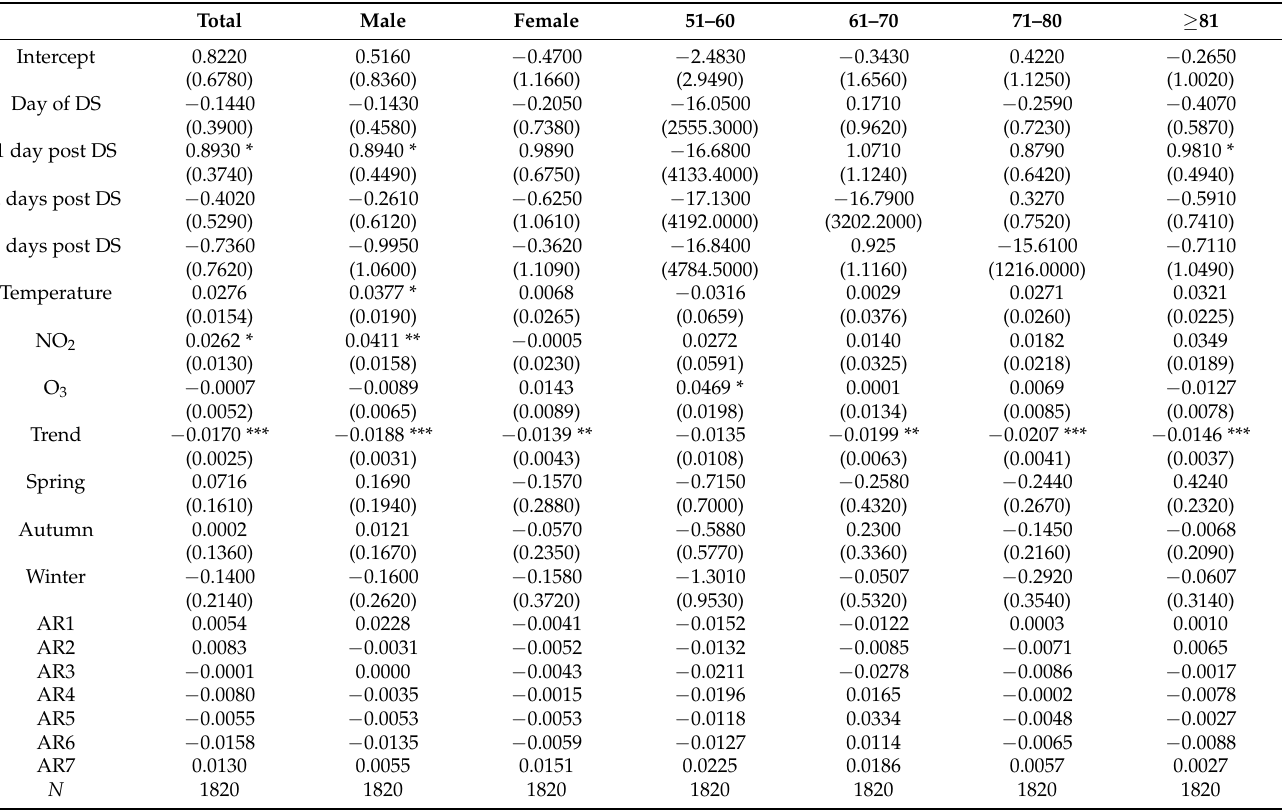
Table 6. Poisson autoregressive analysis for dry AMD inpatient